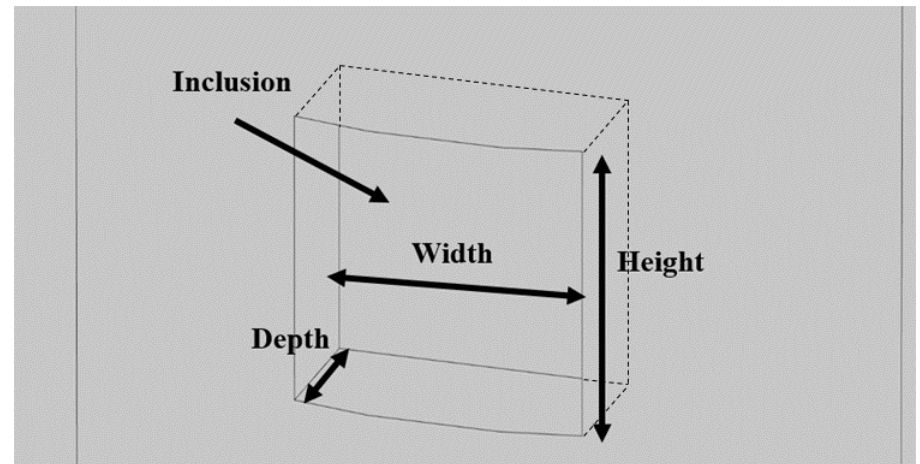
Figure 10. Sketch of void defect for forward and inverse modeling.